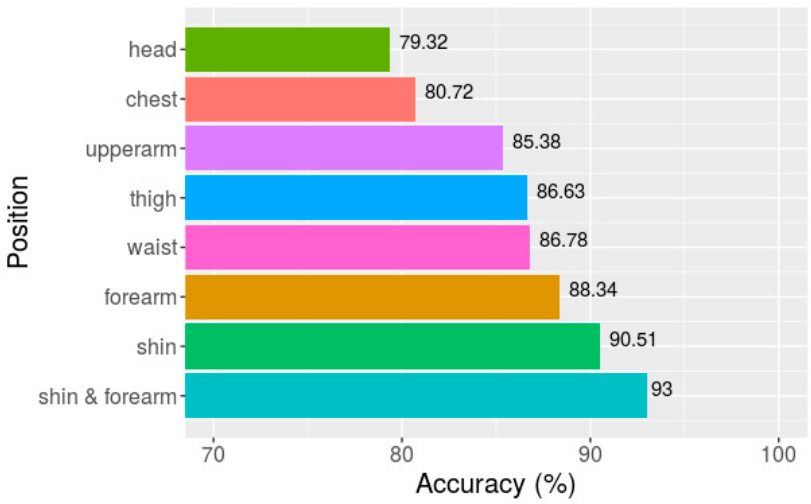
Figure 7. Overall classification accuracies of eight activities based on data from seven single positions and two combined positions.